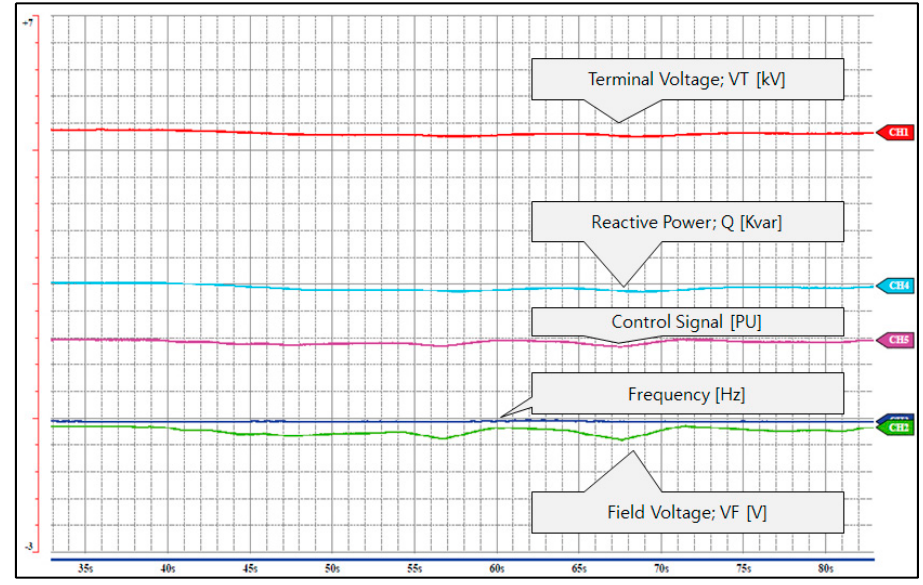
Figure 19. Waveform resulting from the under-excitation limit test (loaded).